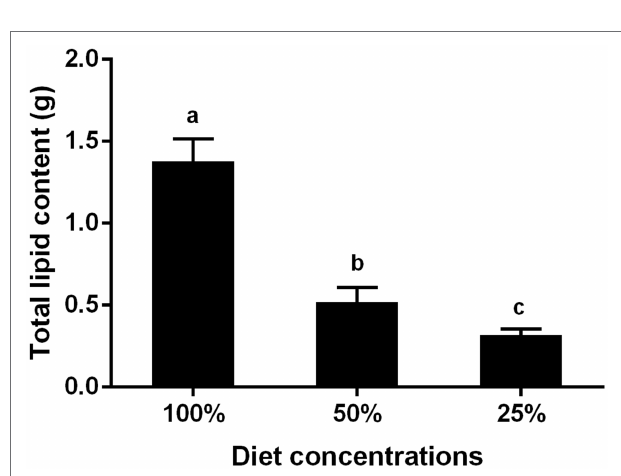
FIGURE 5 | Effects of different nutrient concentrations on the total lipid content in six-day-old BPH adult. Data are presented as mean ± SE ( n = 3); different letters represent significant differences ( p < 0.05, Duncan’s multiple range test).